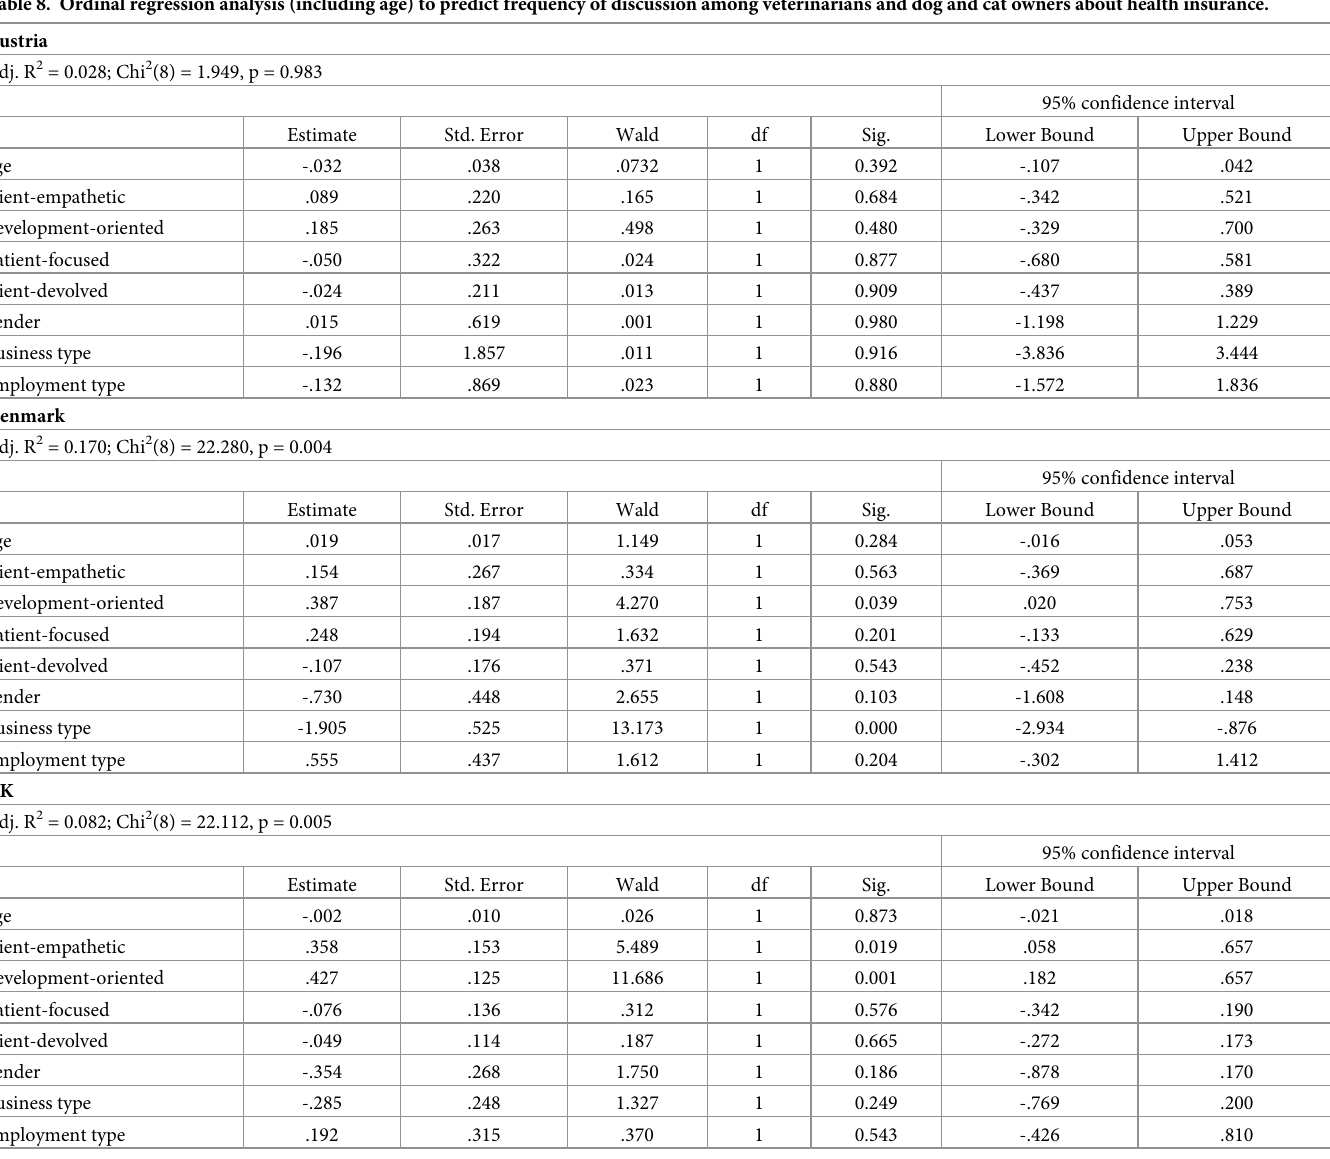
Table 8. Ordinal regression analysis (including age) to predict frequency of discussion among veterinarians and dog and cat owners about health